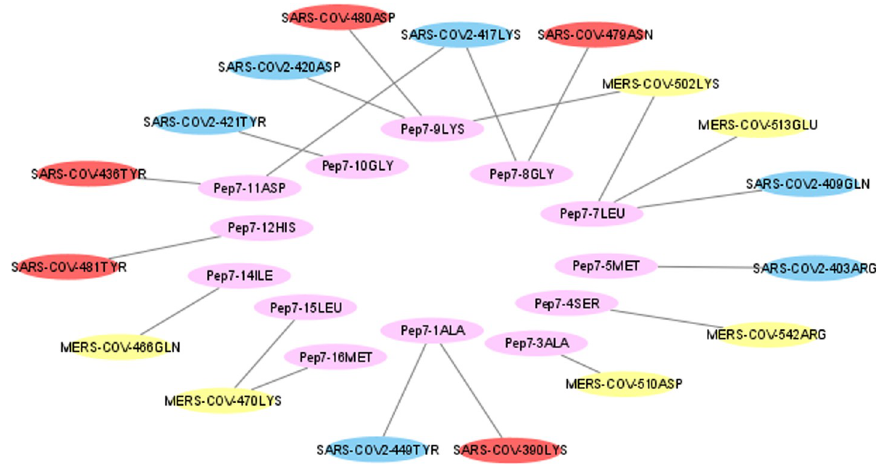
Fig 12. Hydrogen bonds between RBDs and the Peptide